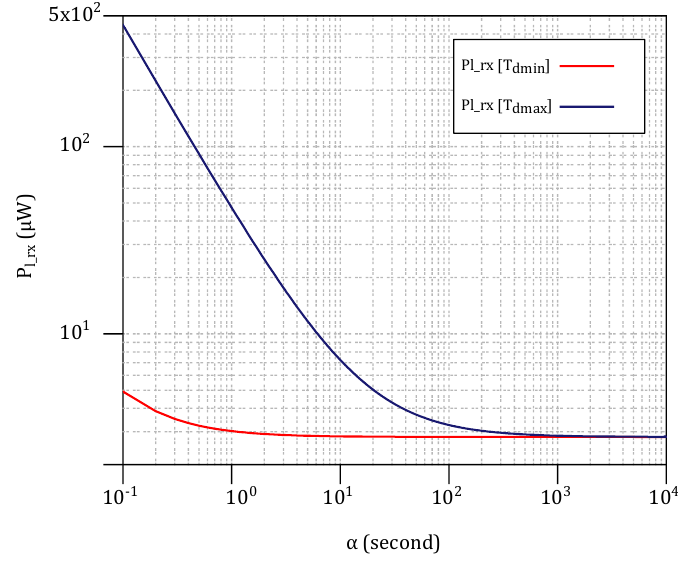
Figure 18. Average power consumption of the Ndrx1’s WuRx ( P l _ rx ) against the variations of α and T d